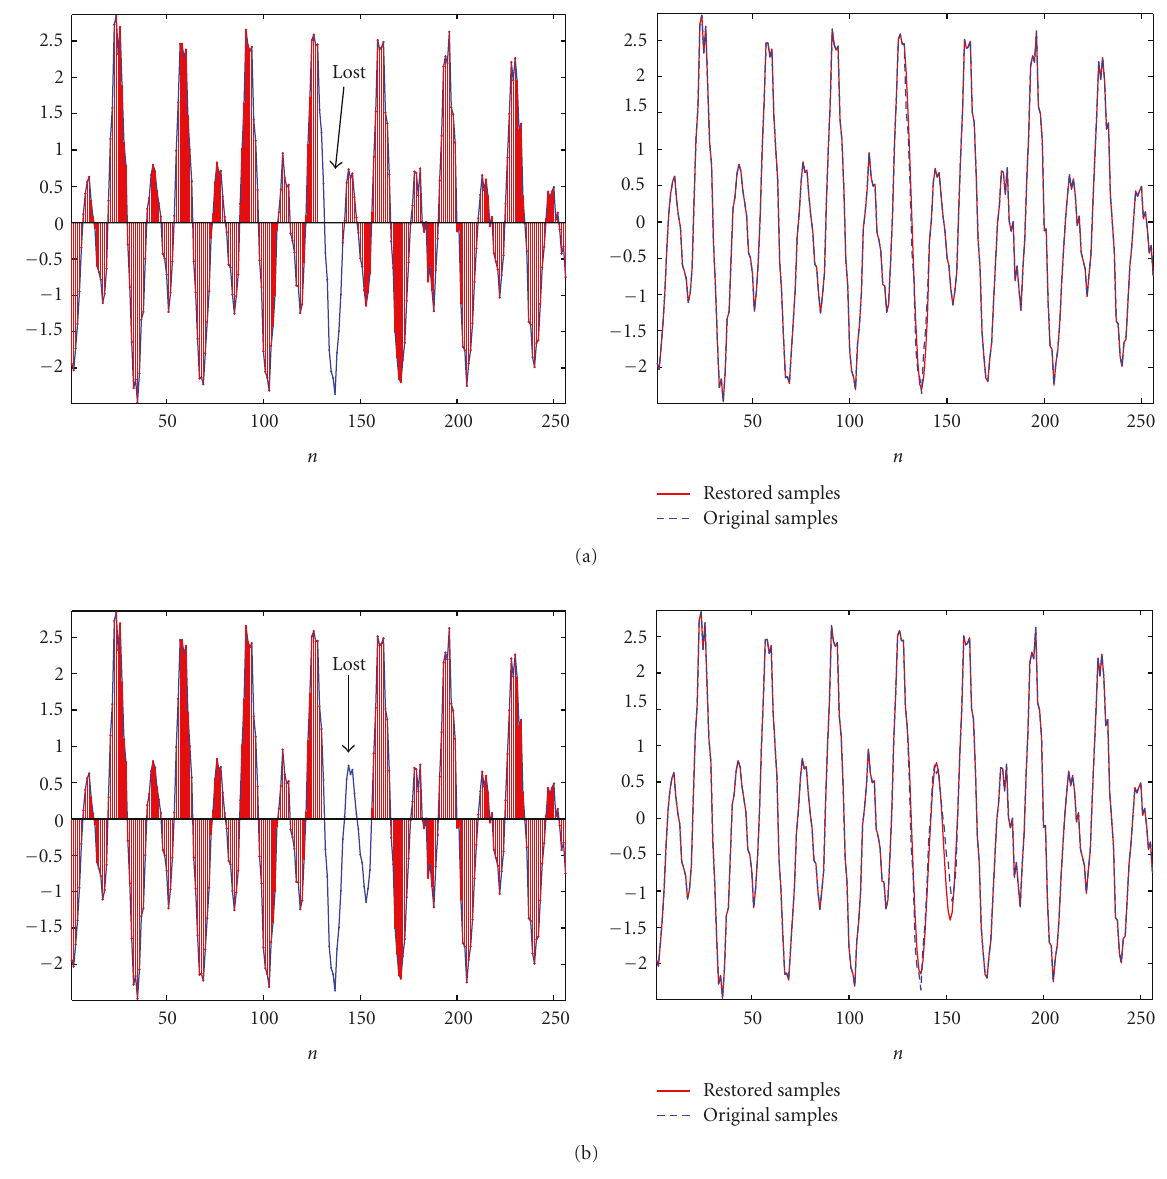
Figure 9: Restored results for continuous lost samples. (a) Restored speech signal from 12 missing data after 10 iterations and (b) restored speech signal from 25 missing data after 70